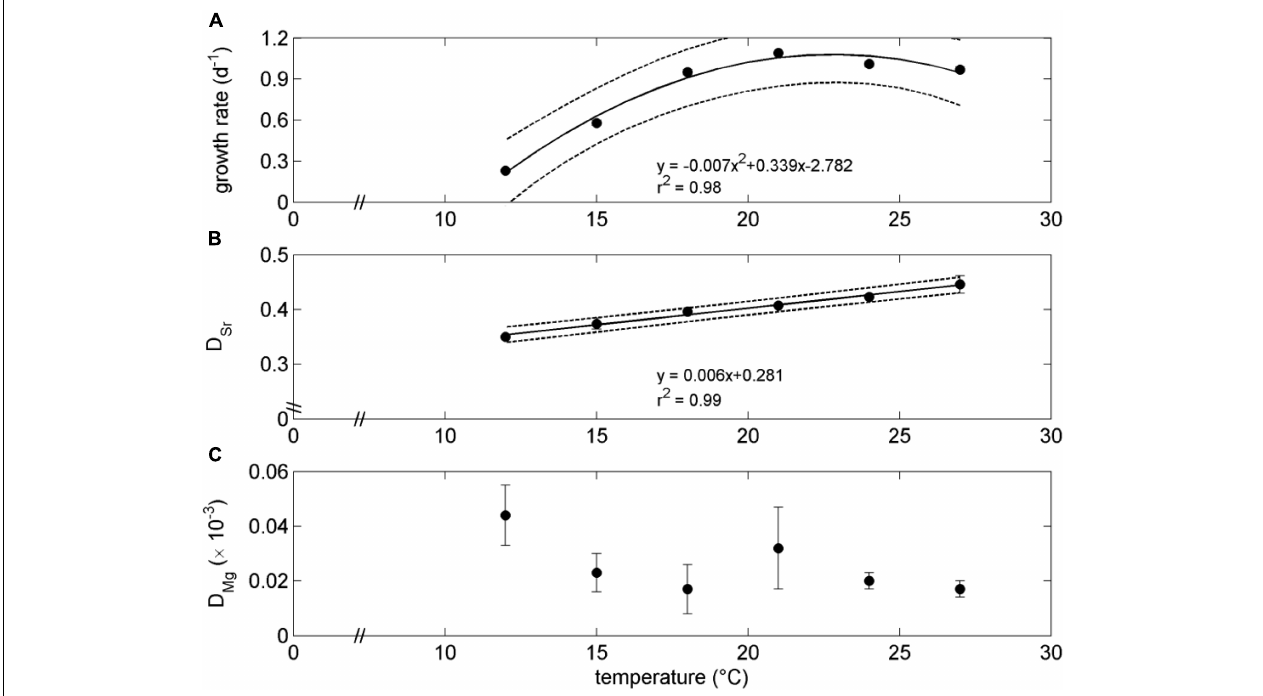
FIGURE 1 | Growth rate (A) of G. oceanica and associated values of D Sr (B) and D Mg (C) for biogenic produced calcite in relation to the experimental applied temperature gradient. TABLE 1 | Coccolith geochemistry and cellular variables of Gephyrocapsa oceanica .